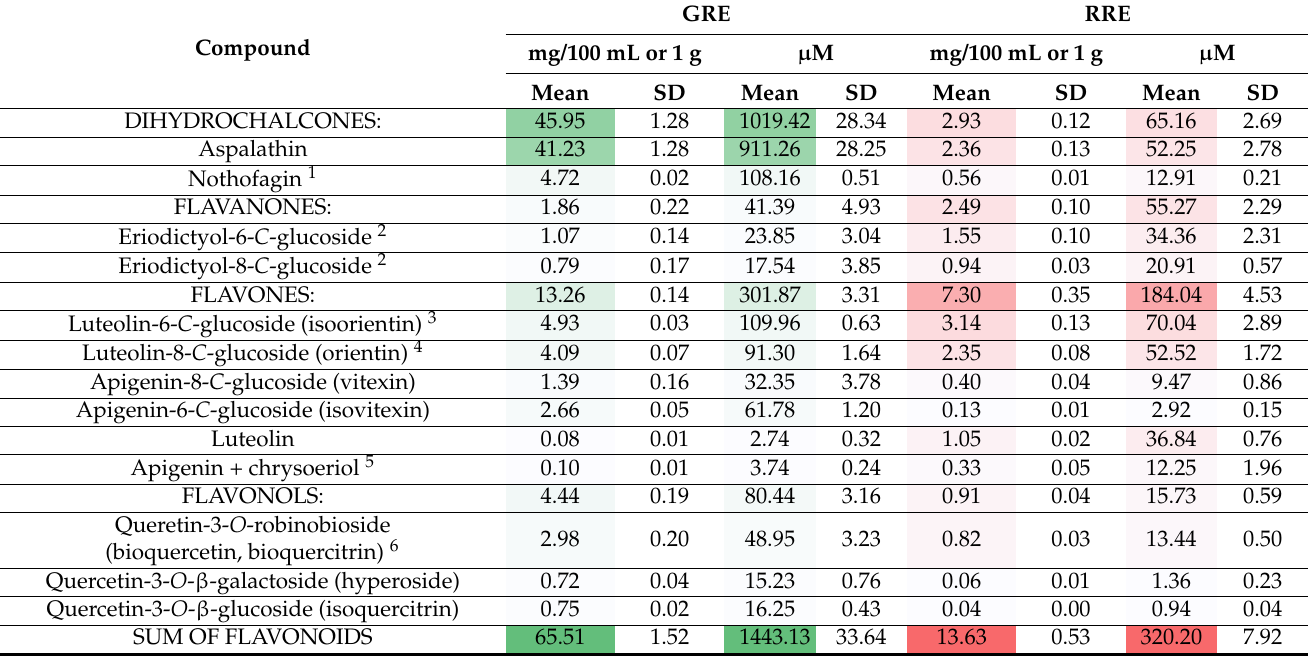
Table 2. Flavonoid content in hydroethanolic extracts from green and red rooibos (GRE and RRE; 1:100, m/v ) expressed in mg per 100 mL of hydroethanolic extract and 1 g of dry plant material and µ M/L. The main components are